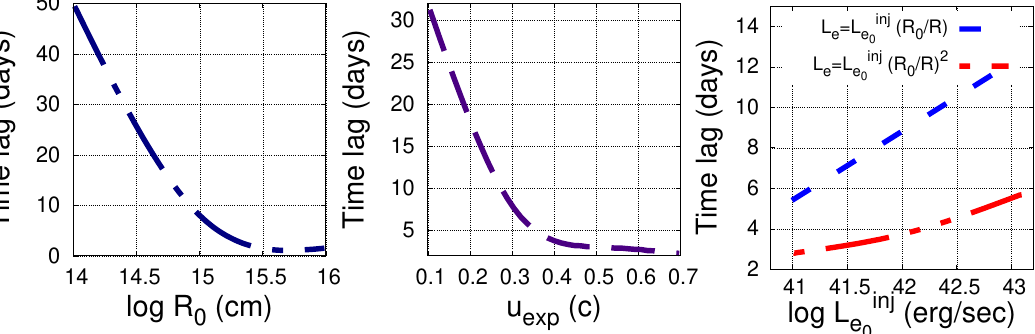
Figure 3. Time lag (in the observer’s frame) between the peaks of the γ -ray (10 23 Hz) and GHz light curves as derived by our model for different initial blob parameters (from left to right): blob radius R 0 , expansion velocity u exp , and electron injection luminosity L inj e marked on the